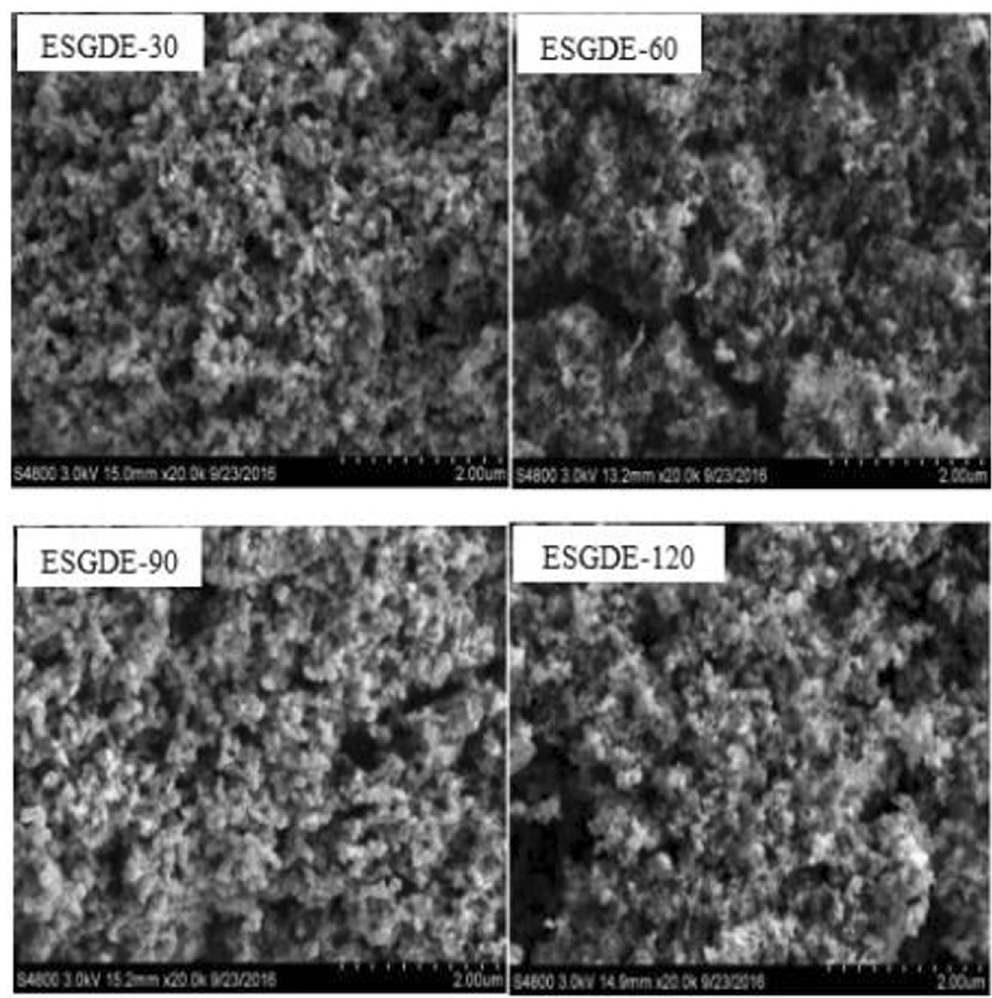
Figure 2. SEM of the catalyst layer in the ESGDEs with different electrodeposition time at magnification of 20